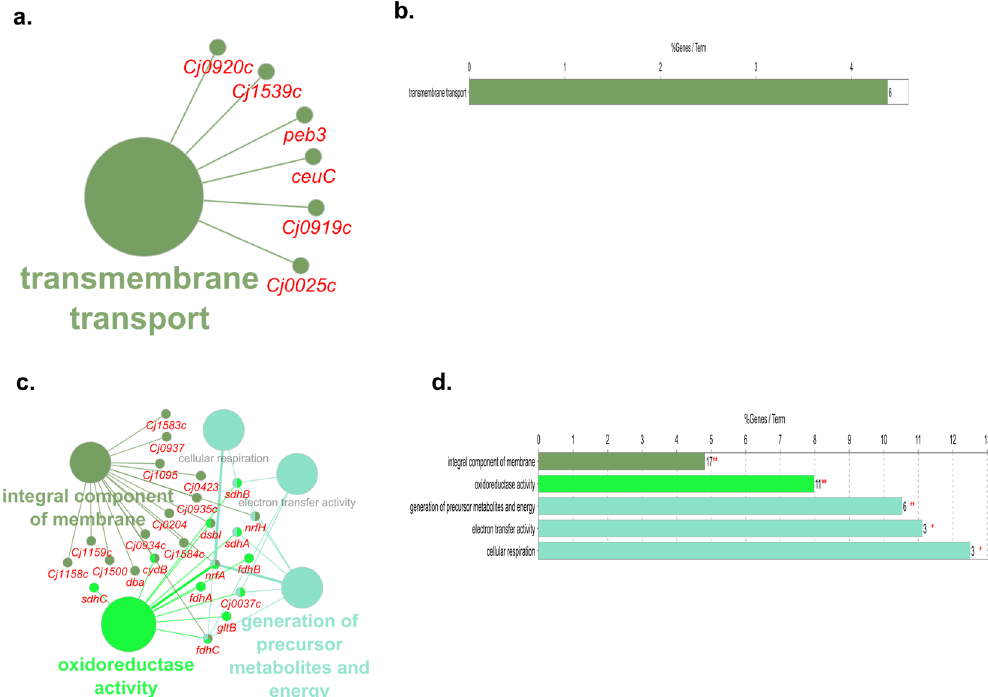
Fig. 4 Biological pathway analysis of DEGs in exposure to ASC at 5 °C. Pathways enriched by mapping the upregulated ( a , b ) and downregulated ( c , d ) DEGs obtained from C. jejuni post-exposure to ASC at 5 °C. DEGs signi fi cantly (FDR < 0.05; log 2 fold change >1 or < − 1) regulated in C. jejuni in response to ASC treatment were mapped in ClueGO and CluePedia plugins in Cytoscape and only the signi fi cantly ( P < 0.05) enriched biological pathways were visualized. In the graph, the length of individual bars indicates the percent of DEGs associated with respective terms out of the total associated